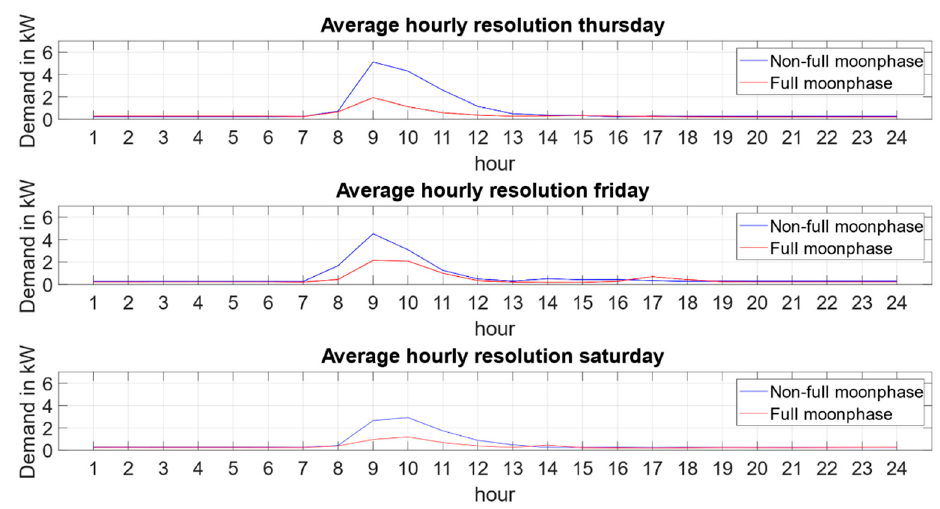
Figure 10. Average hourly electricity demand profile from the measurement during moon phases.